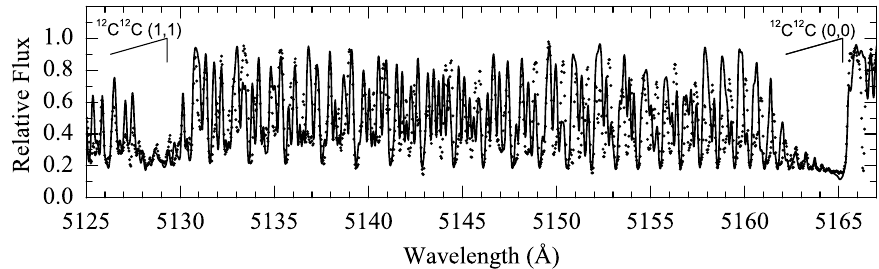
Fig. 7. The observed spectrum of HD 209621 in the wavelength range dominated by the C 2 Swan system (0,0) and (1,1) lines. The synthetic C 2 spectrum is given for the carbon abundance log ϵ (C) =